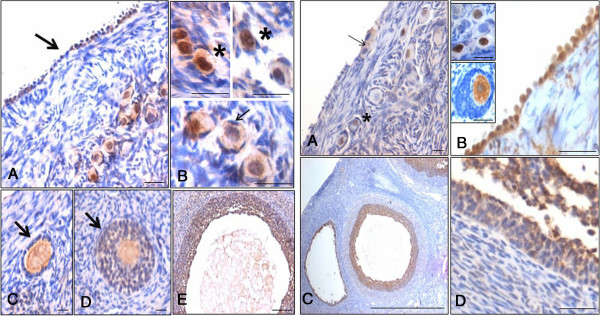
Immunolocalization of FSH receptors on sheep ovarian sections (i) FSH receptors. (A) Ovary surface epithelial cells and primordial follicles showing positive staining for FSHR (B) Primordial follicles (asterix) exhibit positive FSHR staining in the oocyte nucleus as well as in the ooplasm whereas the surrounding granulosa cells are negative for FSHR (arrow) (C) Secondary follicle showing positive staining for FSHR in oocyte nucleus and ooplasm and negative for surrounding granulosa cells (D &E) Developing antral follicles show FSHR positive in both ooplasm and surrounding granulosa cells. (ii) OCT-4 (A &B) certain regions of ovary surface epithelium stain positive for OCT-4. Primordial follicles exhibit positive OCT-4 staining in the ooplasm (arrow) as well as in the nuclei (asterix) of the oocytes. The secondary follicles show distinct staining in the ooplasm whereas the surrounding granulosa cells in both primordial and secondary follicles are negative for OCT-4. (C &D) Large antral follicles have distinct staining for OCT-4 in the granulosa cells whereas the theca cells are negative and note a gradient in the staining intensity at higher magnification. Scale bar is 20 μm. Images of representative area were photographed using 90i Nikon microscope.